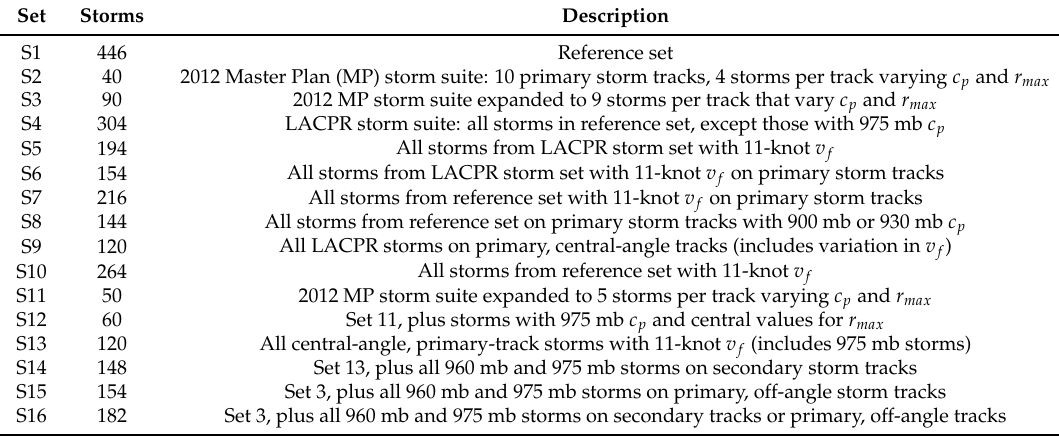
Table 1. Characteristics of storm suites selected for screening-level